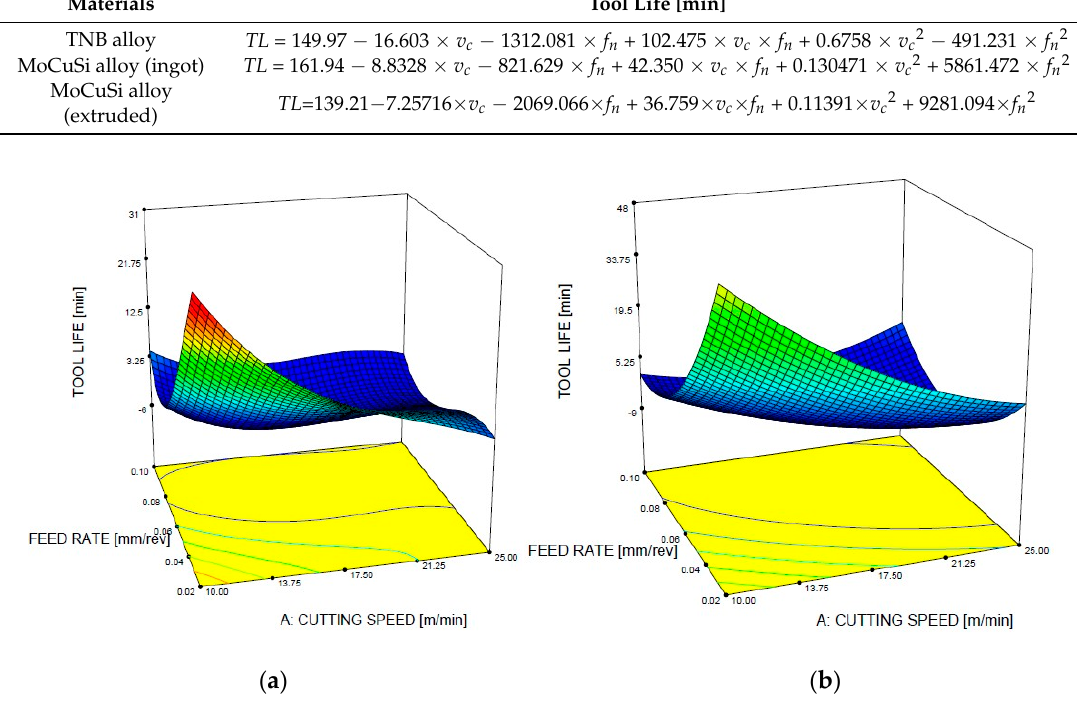
Figure 8. ( a ) Surface response for tool life estimation (TNB); ( b ) surface response for tool life estimation (extruded MoCuSi).